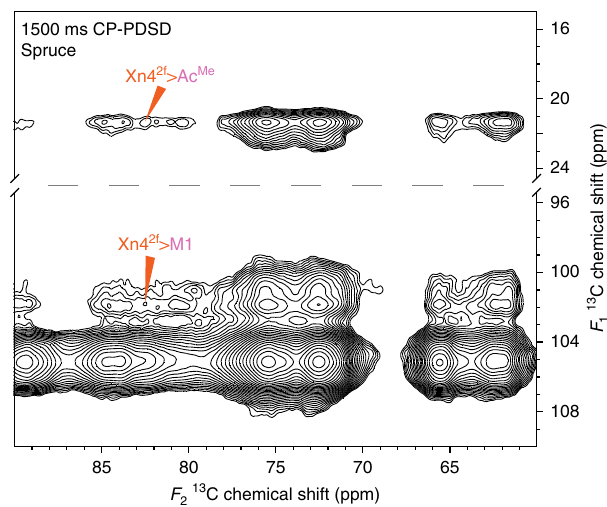
Fig. 4 Xylan and GGM bind to the same cellulose micro fi brils. Acetate methyl and carbon 1 region of a 1500 ms mixing time 13 C CP-PDSD MAS NMR spectrum of spruce. Cross-peaks between xylan and GGM are